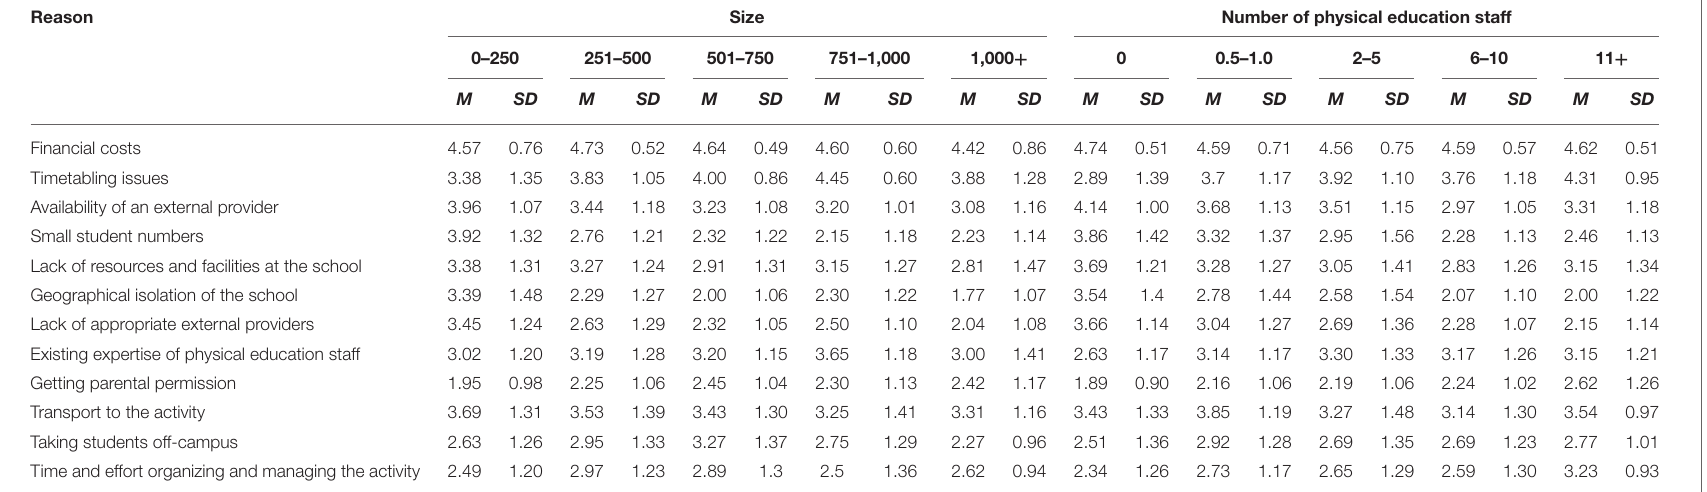
TABLE 5B | Barriers to outsourcing physical education content to external providers by size of school.